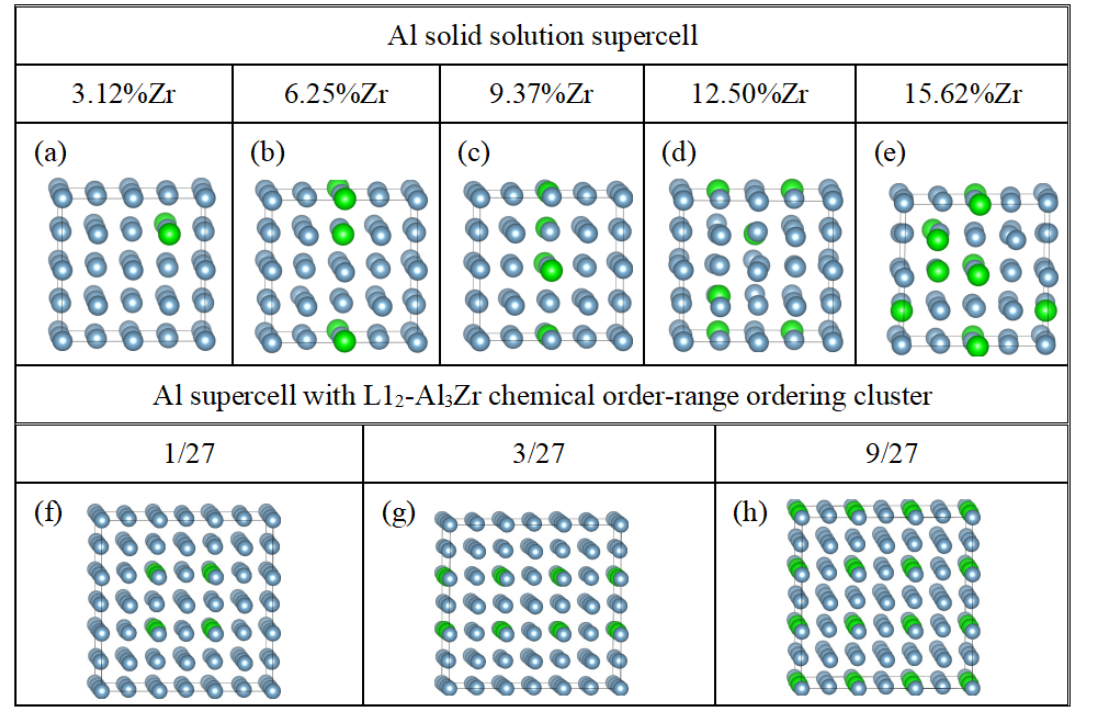
Figure 3. ( a – e ) The supercells of the Al solid solution with varied compositions of the solute atoms Zr after relaxing atoms and volumes and ( f – h ) Al supercells with the chemical short ‐ range ordering clusters L1 2 ‐ Al 3 Zr after relaxing atoms and volumes.